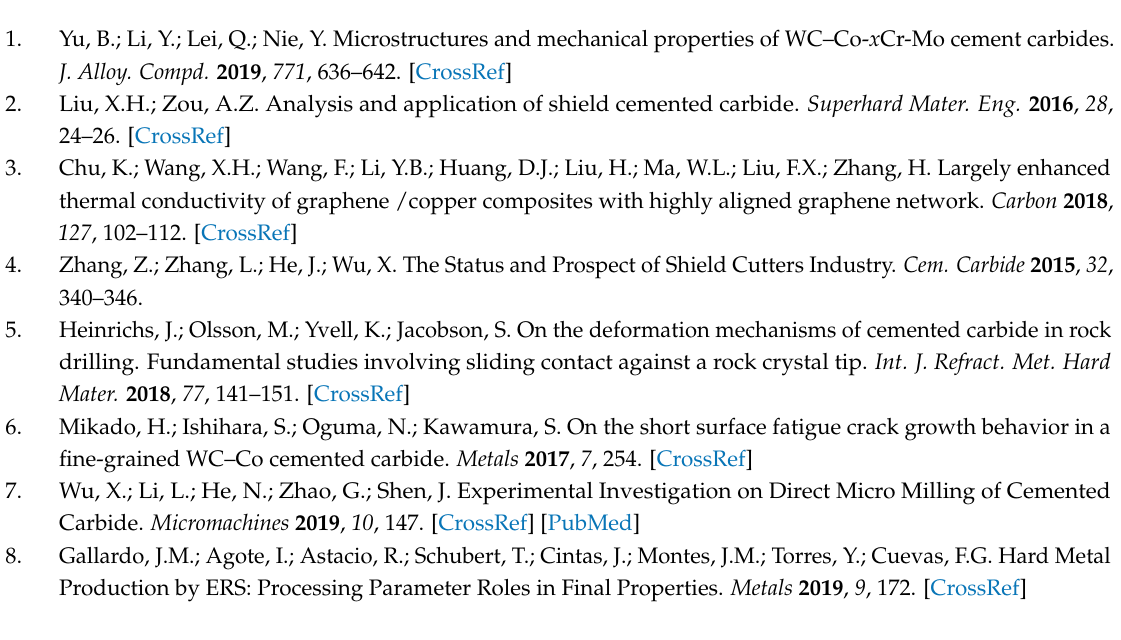
Figure 12. ( a ) Temperature variation of the A-point original sample and the graphene-added sample with time; ( b ) temperature difference between the A-point sample and the graphene sample with time.